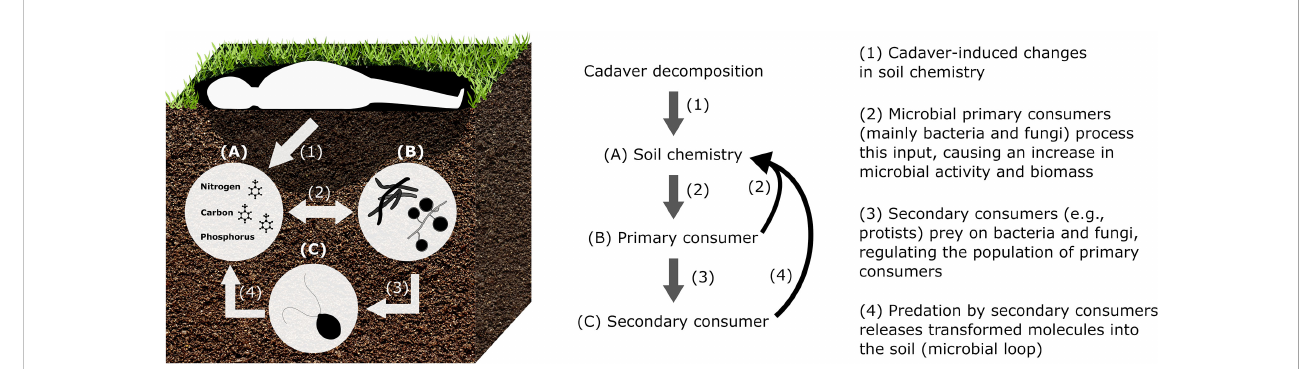
FIGURE 1 Simpli fi ed scheme of cadaver imprint on soil, including coupled chemical-microbial processes. (A) Cadaver-induced nutrient and matter changes soil chemistry. (B) Microbial primary consumers (mainly bacteria and fungi) process the cadaver-derived input and subsequent increase in microbial activity and biomass. (C) Secondary consumers (e.g., protists) prey on bacteria and fungi, and thus, regulate the population of primary consumers and the release of transformed molecules into the soil. Please note, temporal and spatial facets are not considered, since largely unknown. Furthermore, the rest of the food chain including plants, meso- and macro-fauna is not shown since we focus on soil chemistry and